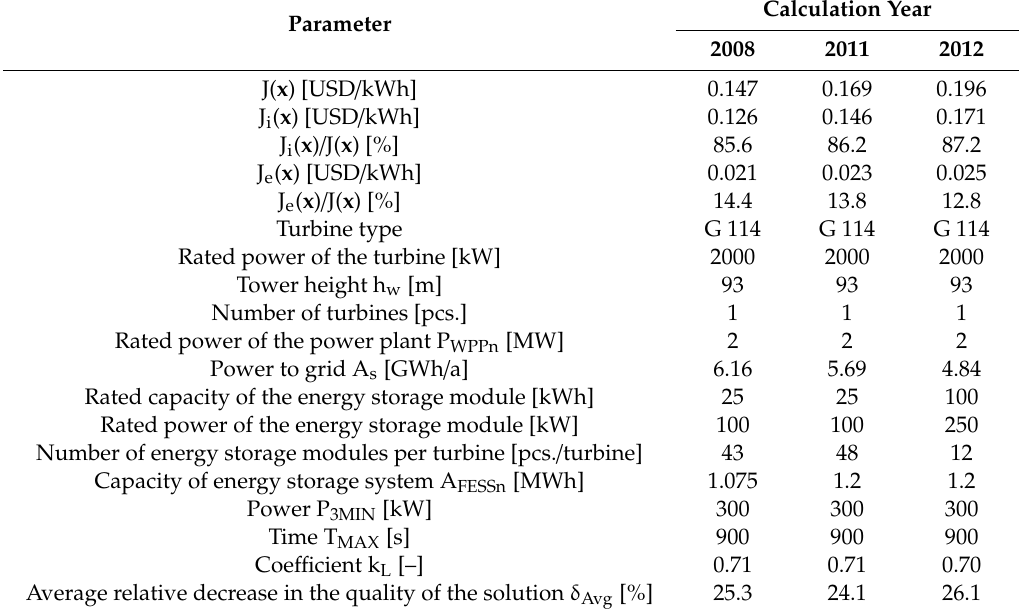
Table 1. Optimisation results for years: 2008 (best wind conditions), 2011 (average wind conditions), 2012 (worst wind conditions) and system parameters: P 3MIN = 300 kW, T MAX = 900 s, k L ≥